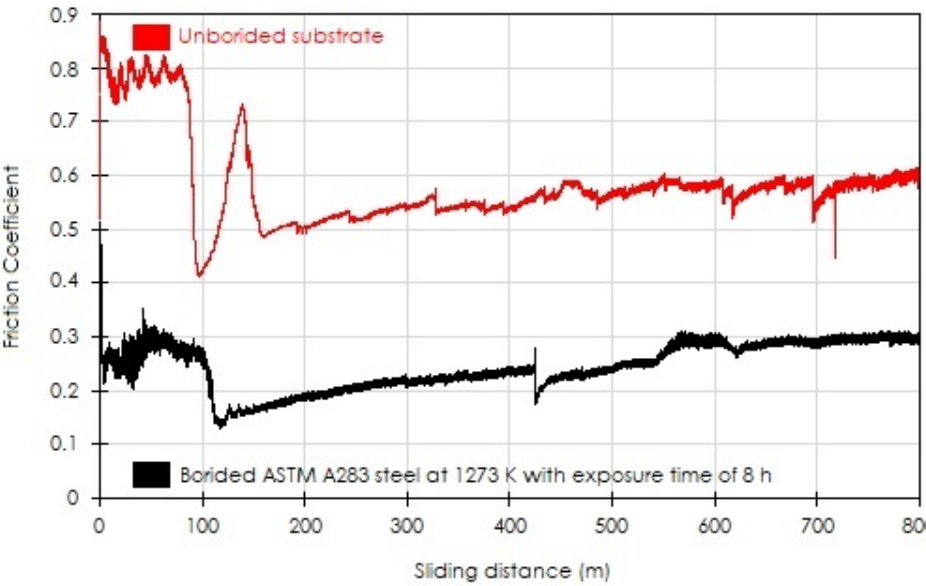
Figure 11 . The coefficient of friction (COF) depends on the sliding length on the surfaces of un- treated and boronized ASTM A283 steel for 8 h at 1273 K. and boronized ASTM A283 steel for 8 h at 1273